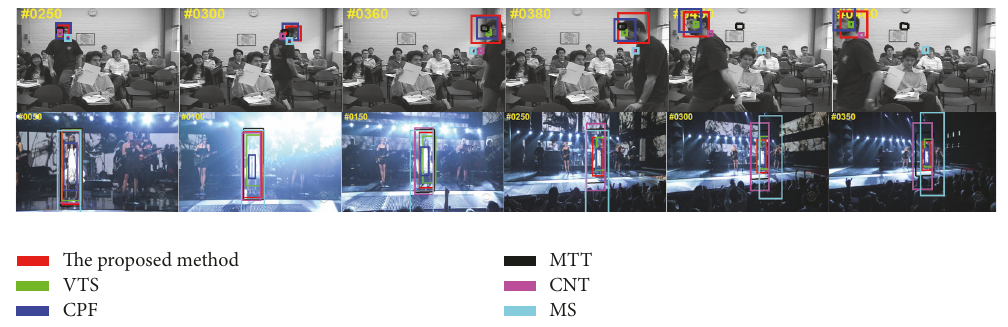
Figure 9: Qualitative evaluation about the tracker over sequences freeman3 and singer1